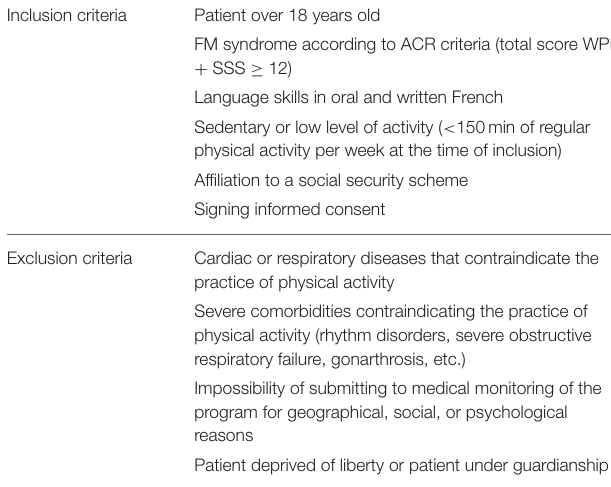
TABLE 1 | Eligibility